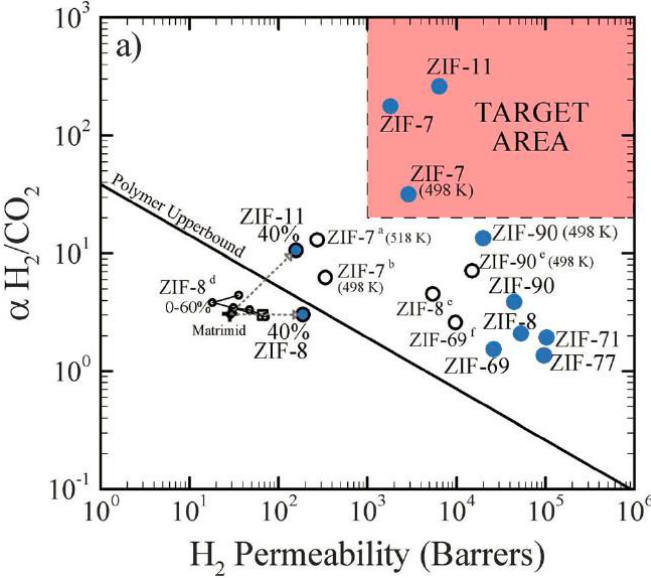
Figure 8. Predicted intrinsic (solid) and experimental (empty) H 2 /CO 2 separation performance of ZIF membranes. Figure modified with permission of the authors of [119].